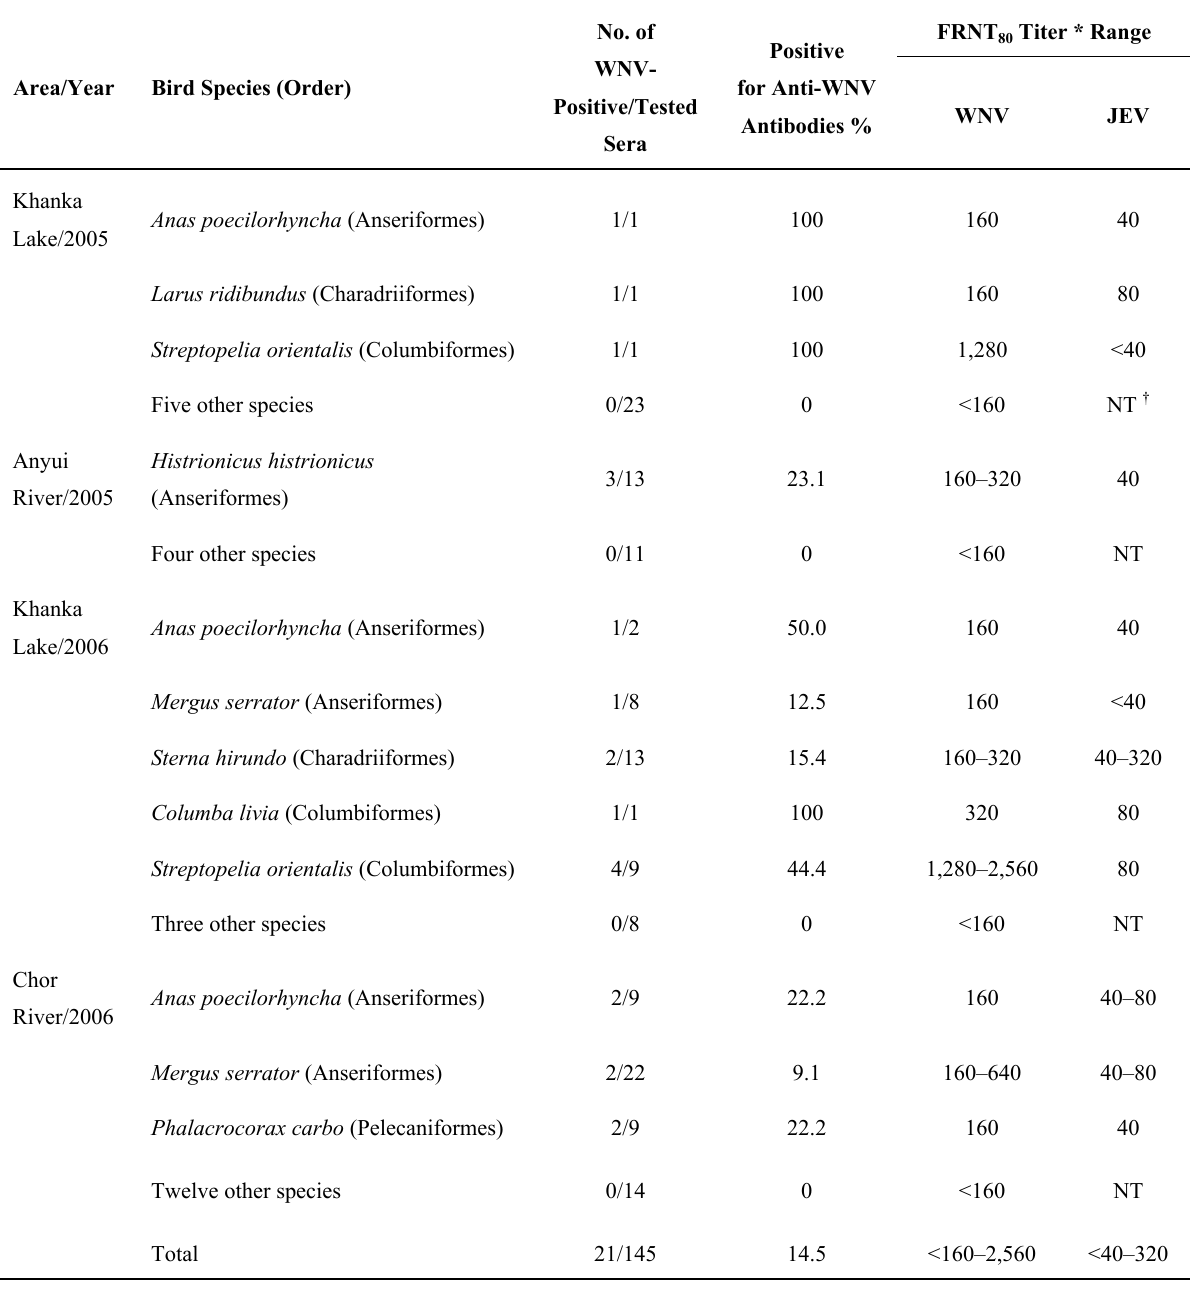
Table 2. Seroprevalence of wild birds collected in Far Eastern Russia (2005–2006) with WNV and/or JEV neutralizing